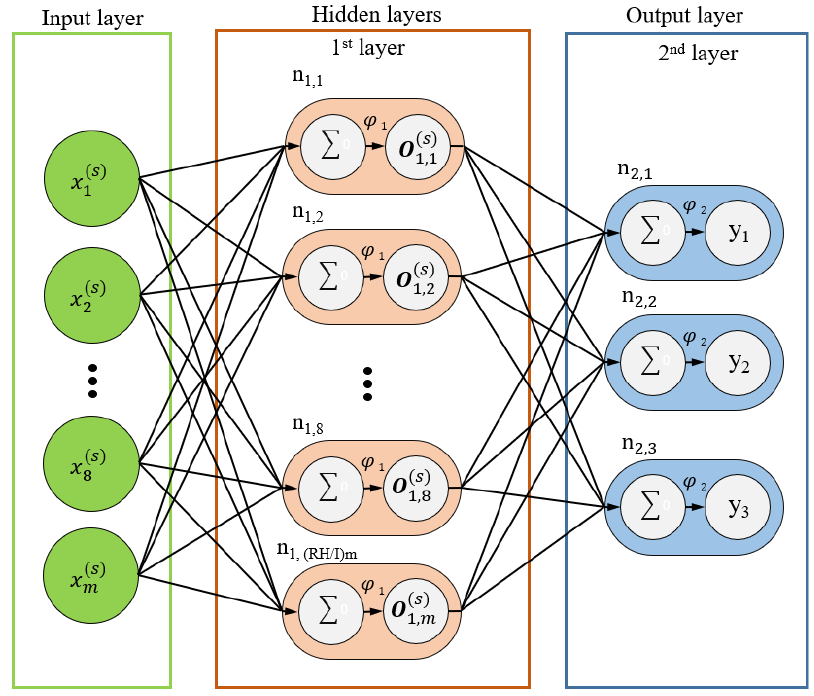
Figure 11. MLP framework used in this study.